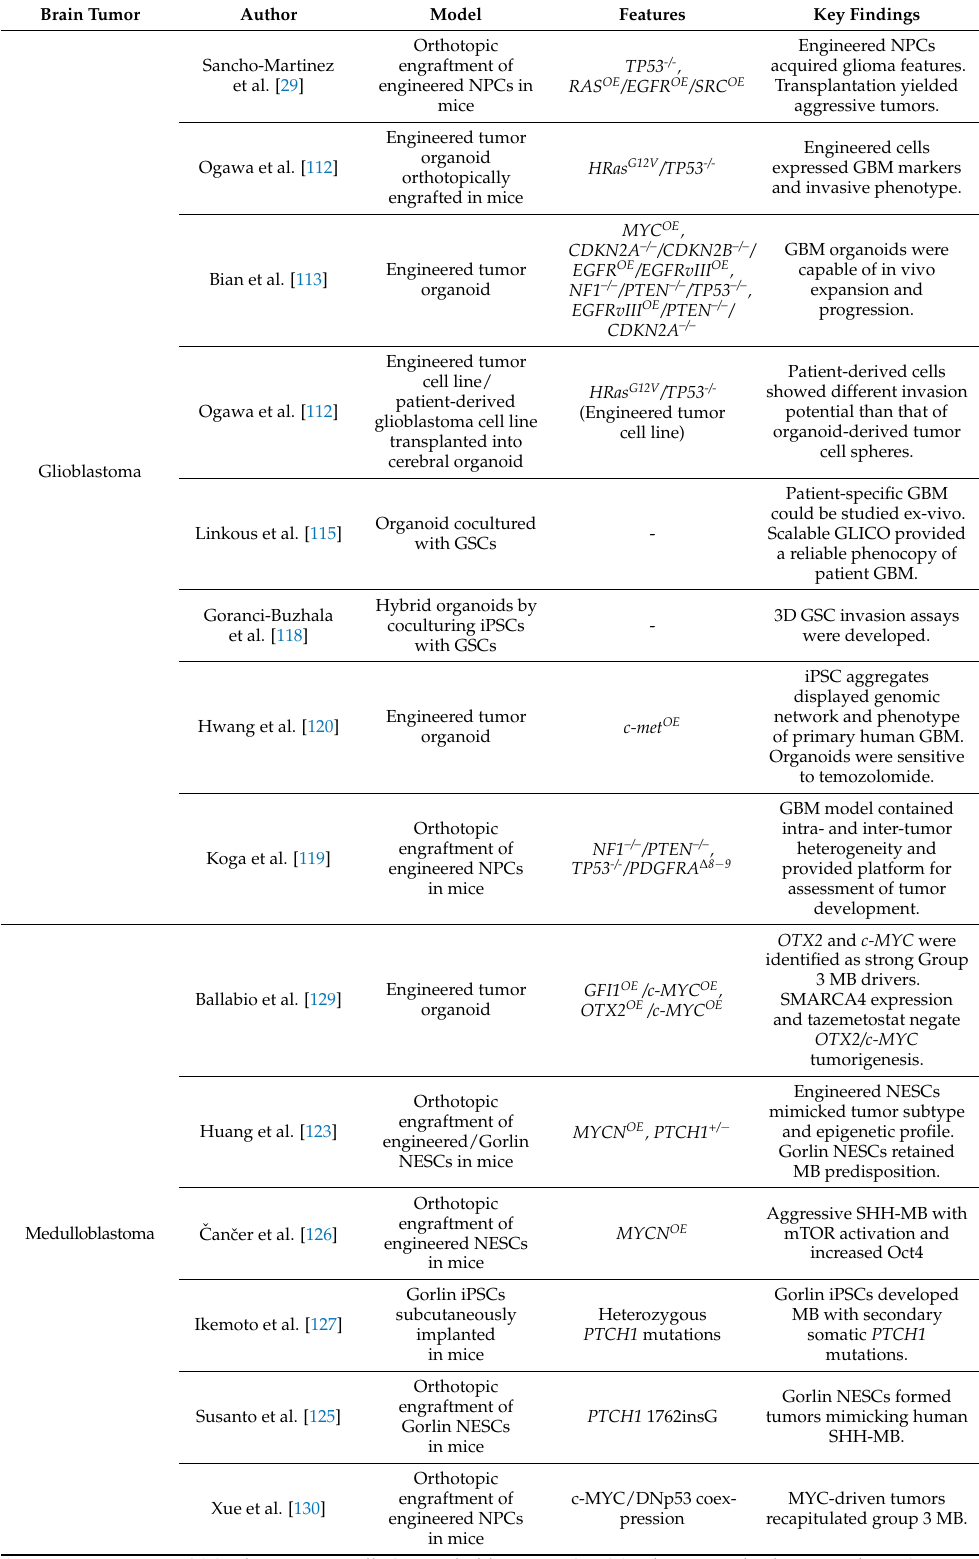
Table 1. Induced PSC-derived malignant brain tumor models and their